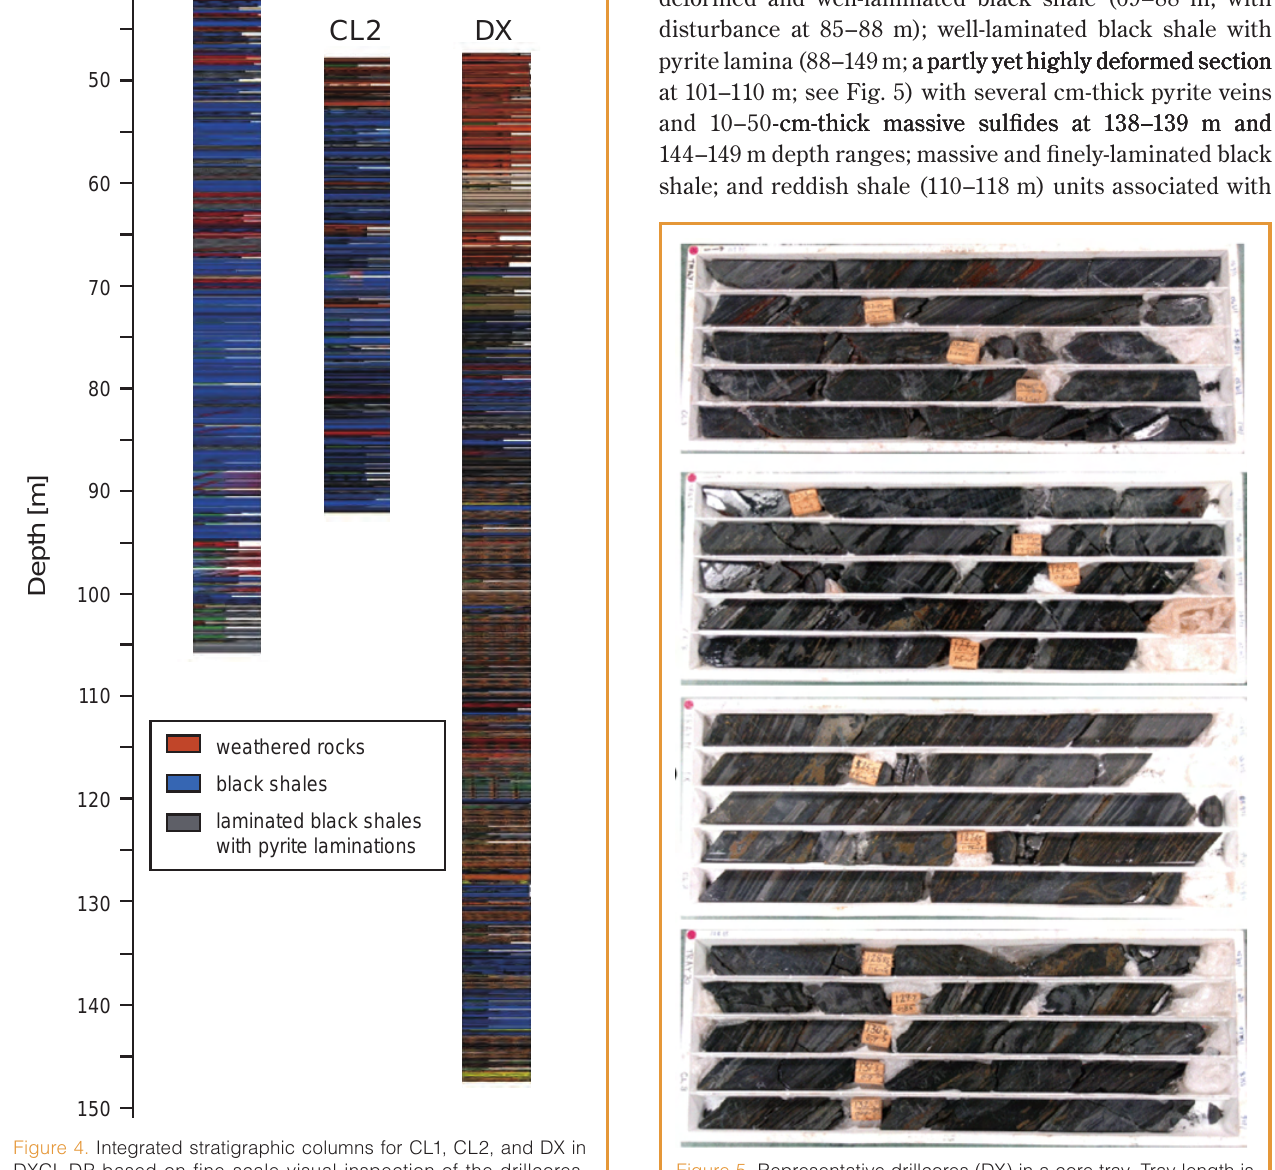
Figure 5. Representative drillcores (DX) in a core tray. Tray length is approximately 1 m. Modern-weathering-free black shales preserve pyrite laminations and